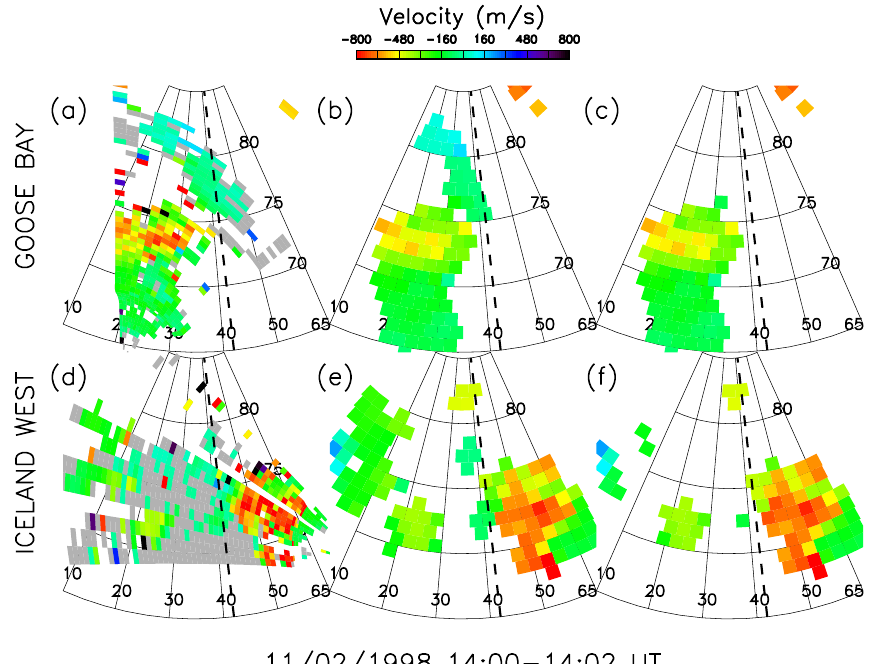
Fig. 8. Line-of-sight velocity map in geomagnetic coordinates for a single scan interval on 11 February 1998, (14:00–14:02 UT) for: (a) Goose Bay – the grey region represents data identified as ground backscatter by the raw data processing. (b) Goose Bay – gridded velocity data using default processing. (c) Goose Bay – gridded velocity data using velocity-range gate filtering. (d) Iceland West – the grey region represents data identified as ground backscatter by the raw data processing. (e) Iceland West – gridded velocity data using default processing. (f) Iceland West – gridded velocity data using velocity-range gate filtering. The bold dashed lines represent the location of magnetic local noon.